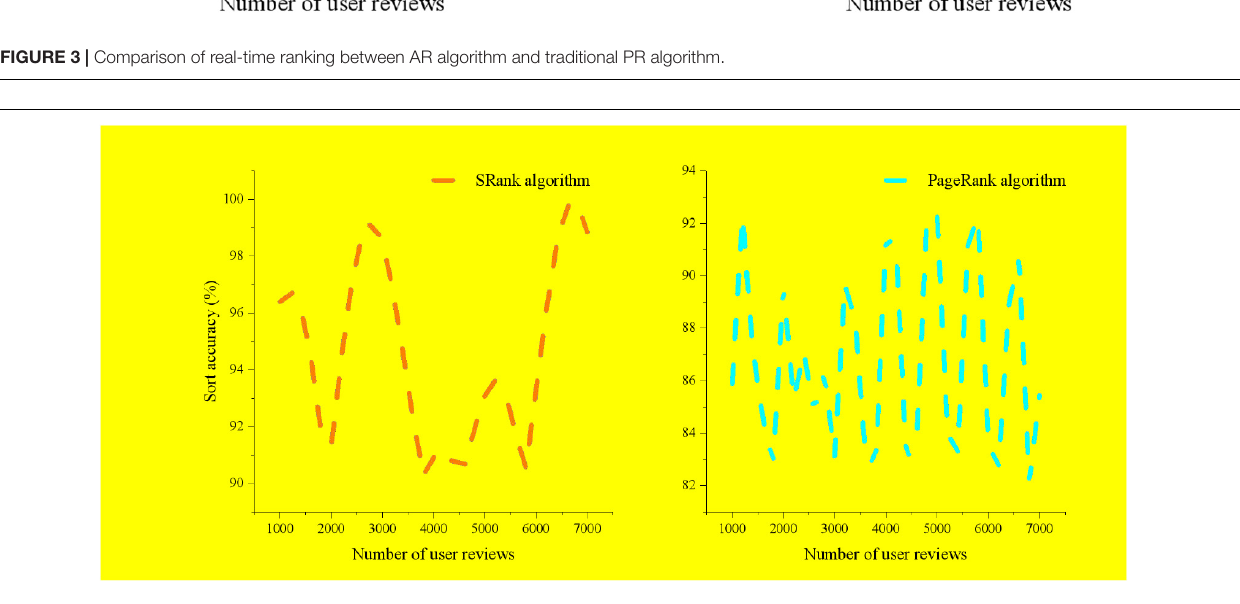
FIGURE 4 | Comparison of the accuracy of pre-sorting and final